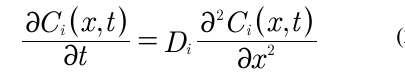
Table 1. Comparison between the obtained values of activation energies of the boron. Activation Energy Q